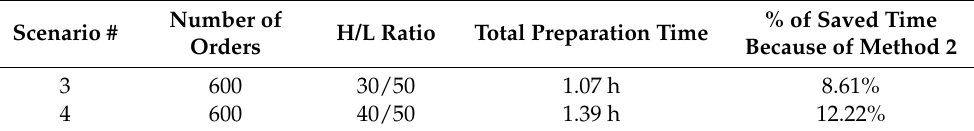
Table 6. Results when available time for preparation is